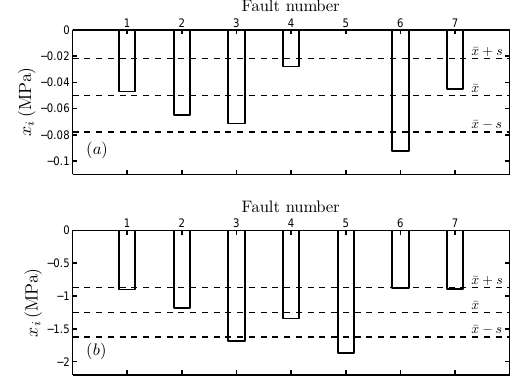
Figure 7. Components of the state vector x at the beginning (a) and at the end (b) of the 2012 Emilia seismic sequence, as calculated from the model. Faults are numbered from west to east. The mean ¯ x and the standard deviation s are shown.